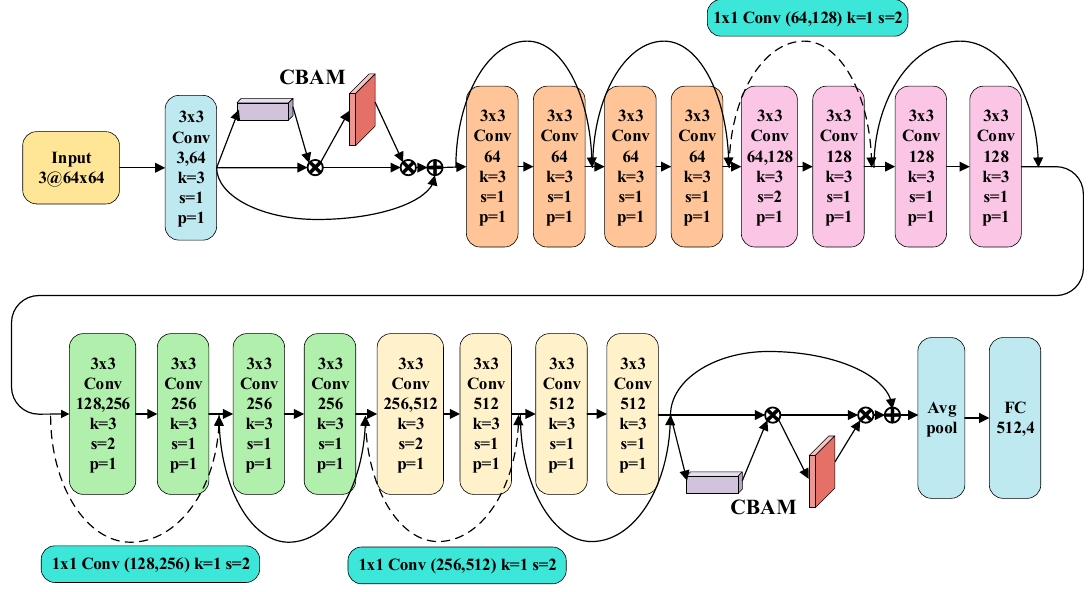
Figure 6. The basic structure of the proposed CBAM-ResNet.